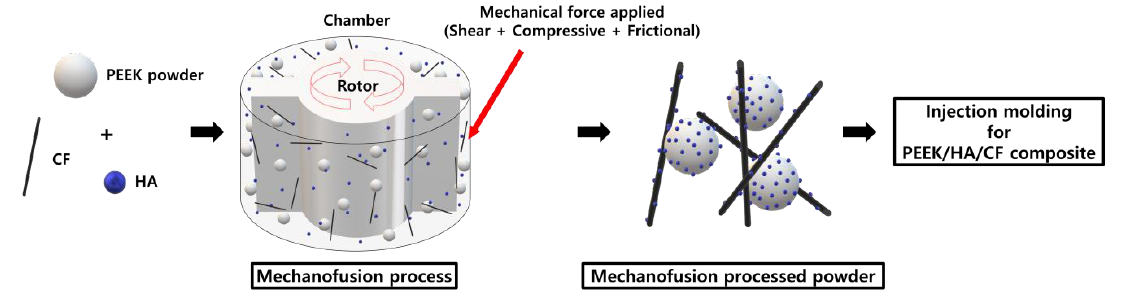
Figure 1. A schematic of mechanofusion process to prepare the PEEK/HA/CF composite.